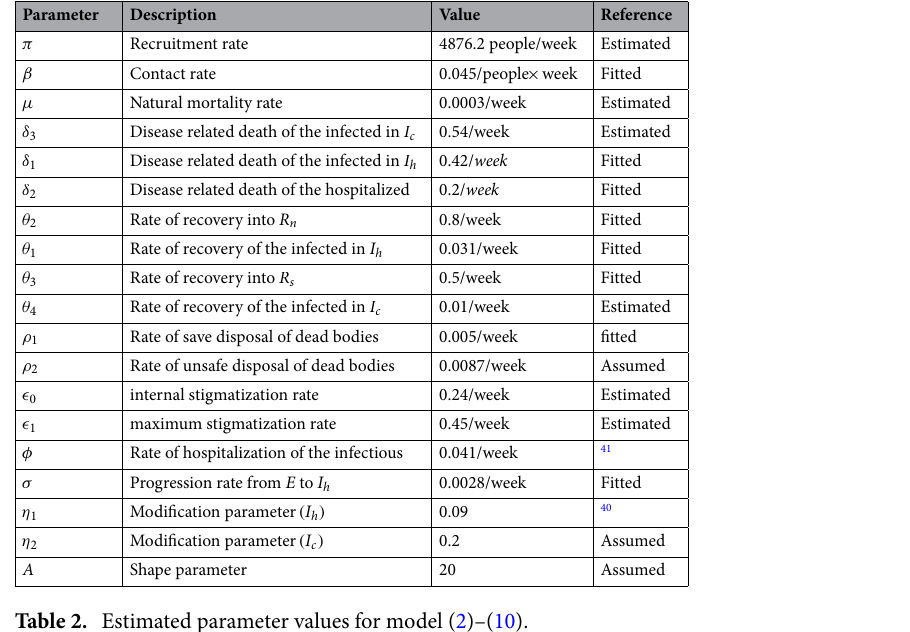
Figure 6a depict an increase in the number of infected individuals who hide their infection and refuse to seek hospital care with increasing values of ǫ 0 and ǫ 1 . ǫ 0 = 0.24 and ǫ 1 = 0.45 are the baseline stigma values (estimated). They represent the average values of internal and external stigma respectively for which EVD will persist in the population. In Fig. 6a, we observe a slight increase in the infected stigmatised population as the stigma parameter values are raised above the baseline values ( ǫ 0 = 0.4 and ǫ 1 = 0.6 ), and a fall in the infectious